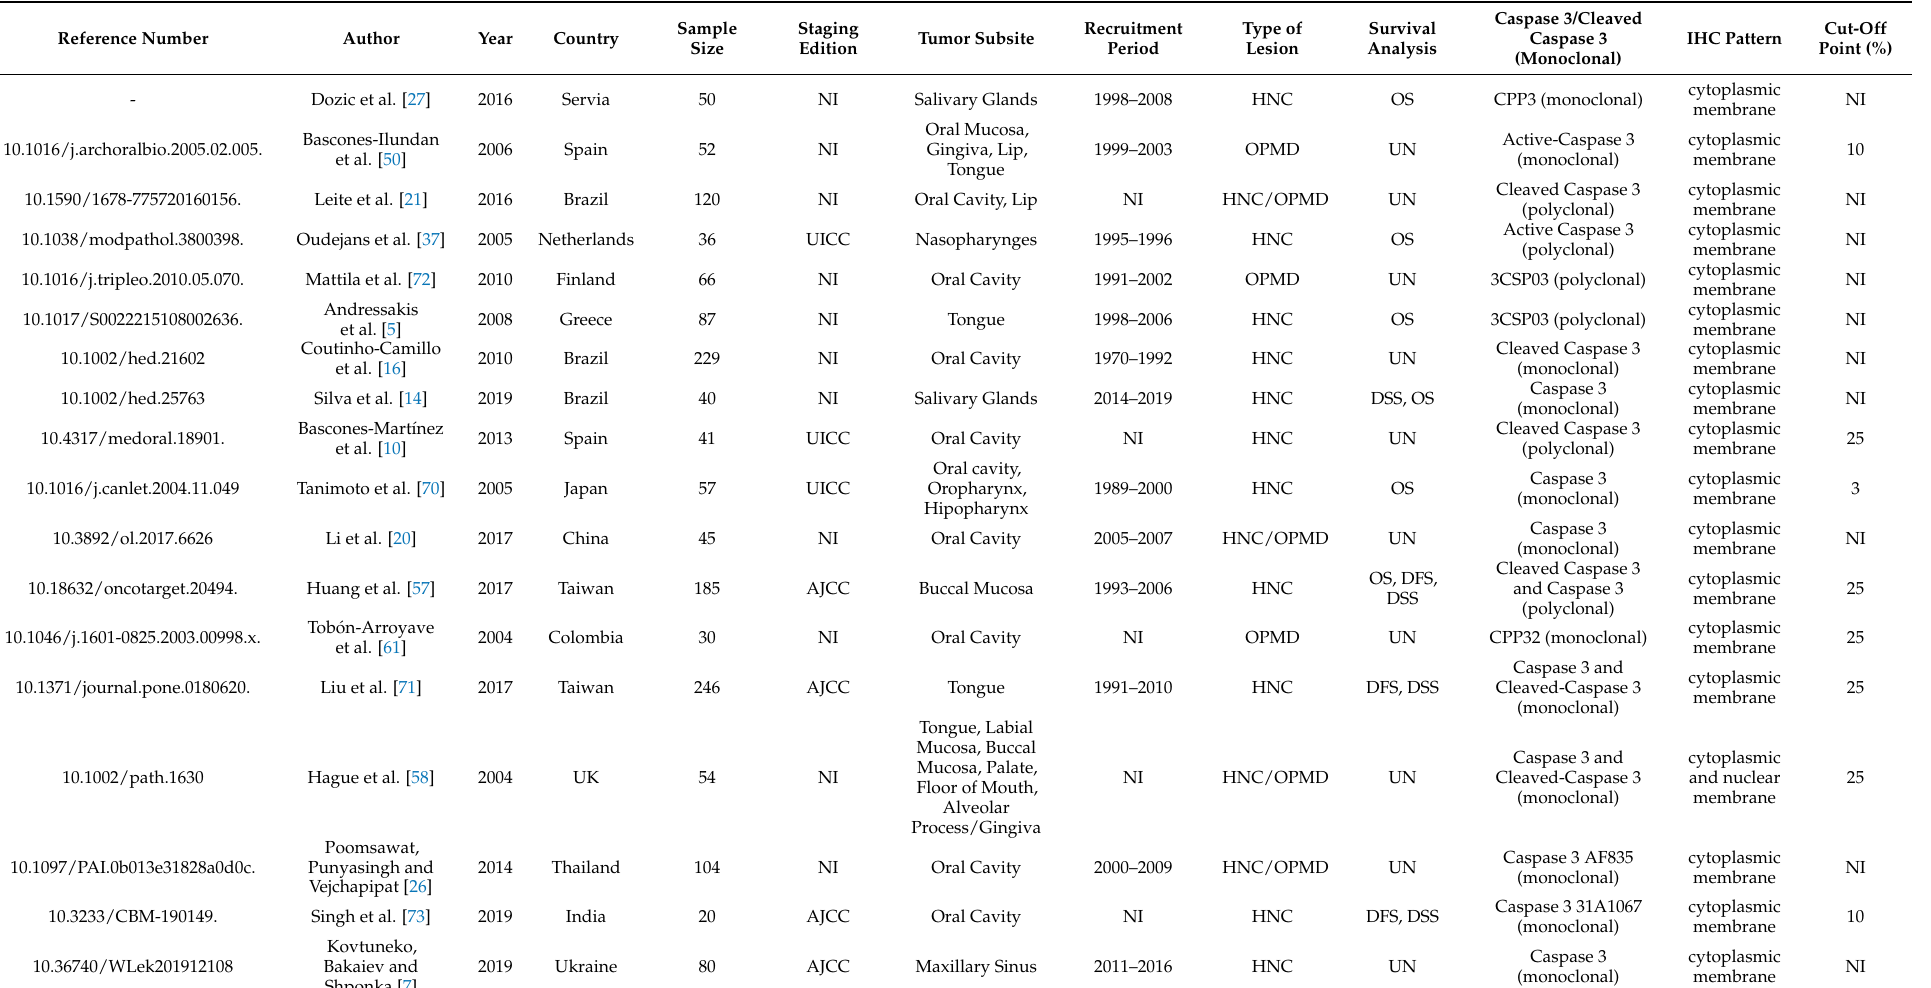
Table 1. Descriptive summaries of the included studies. NI = Non-Informed; UICC = Union for International Cancer Control; AJCC = American Joint Committee